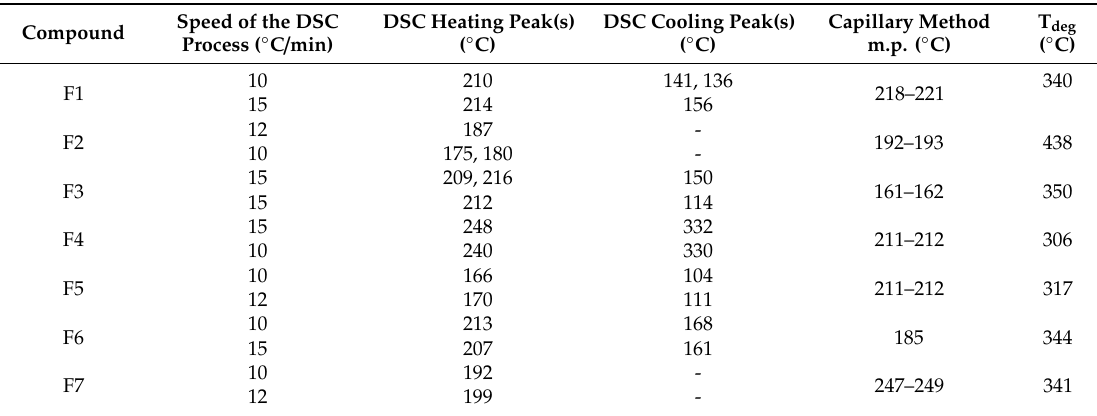
Figure 5. Typical thermogravimetric (TG) curves for derivatives F1 to F7 (described in Table 1). Table 5. Parameters of the DSC curves.